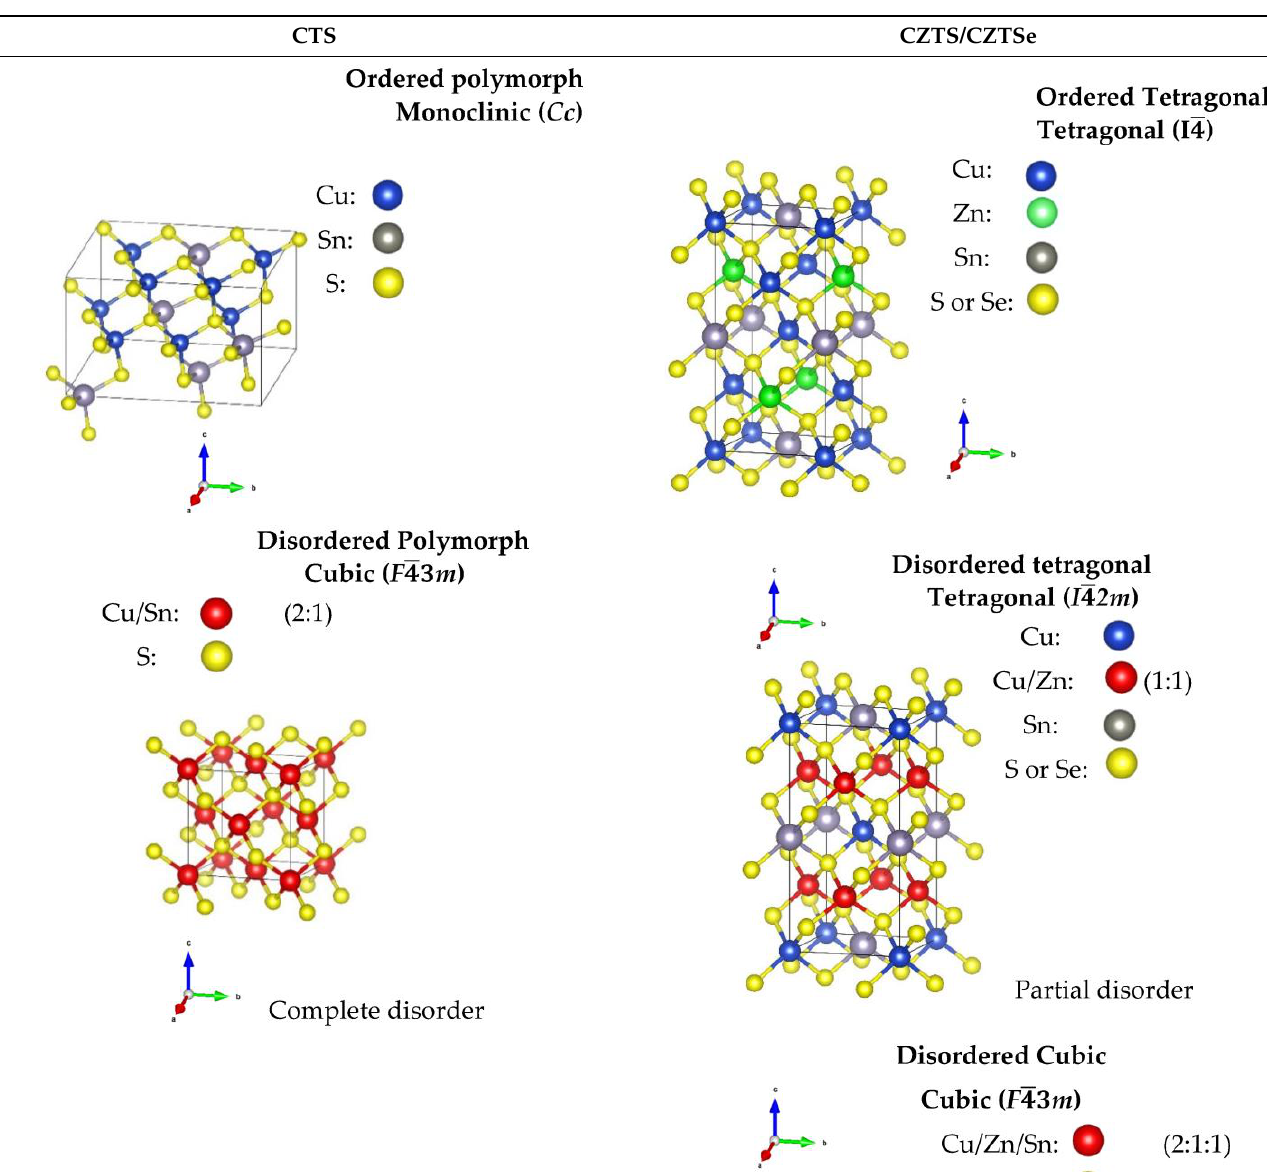
Table 1. Structural information and band gap values for the different polymorphs of CTS, CZTS, and CZTSe. The structures have been produced using VESTA software [65].